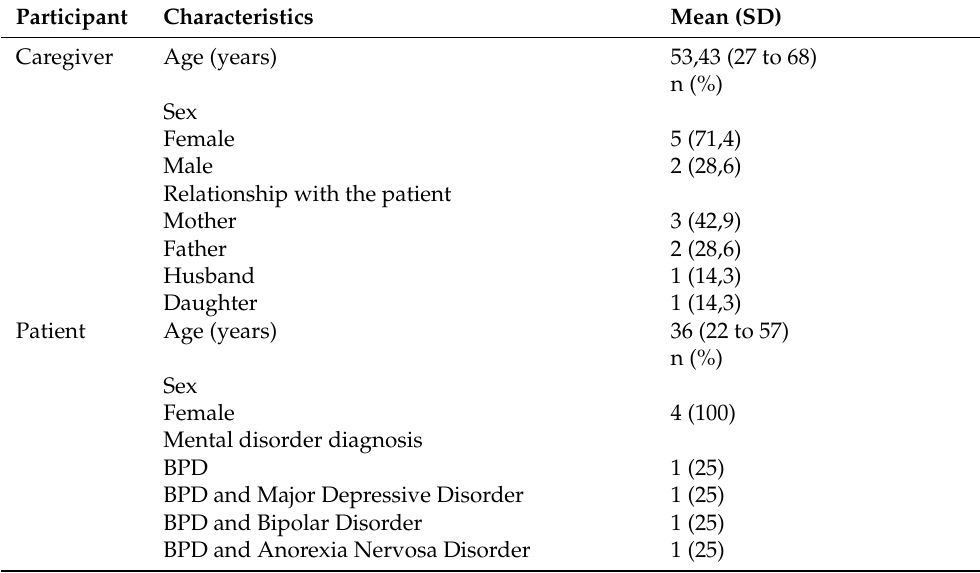
Table 2. Characteristics of the relatives and